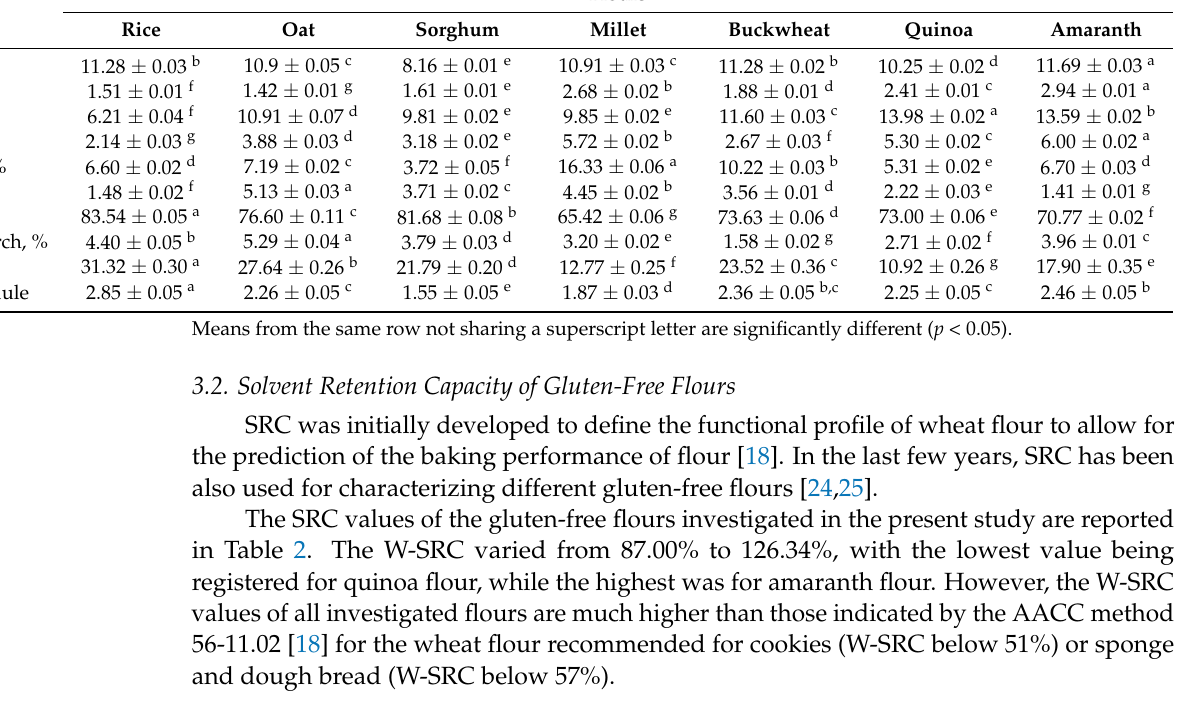
Table 2. Solvent retention capacity of gluten-free flours.